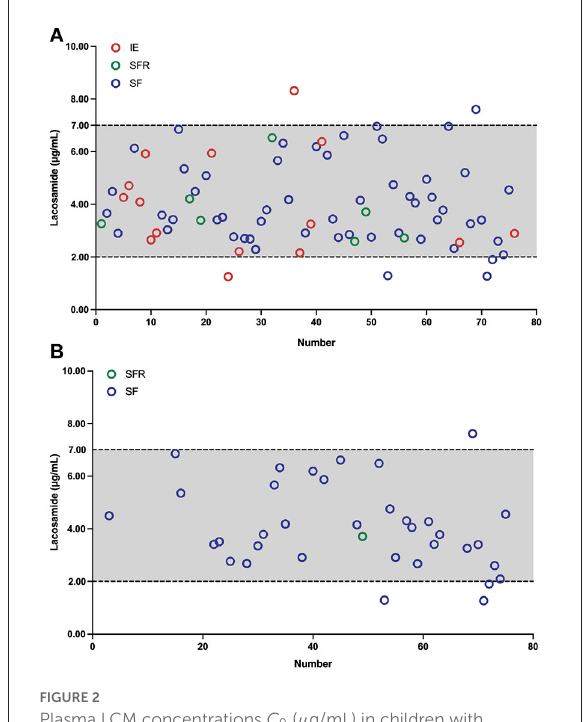
FIGURE2 Plasma LCM concentrations C 0 ( µ g/mL) in children with epilepsy, the x-axis shows the number of patients. Two dotted lines depict the measured C 0 values in our findings. Different colored circles denote C 0 measurements after the maintenance dosage. Red circles indicate C 0 measurements of the ineffectiveness (IE) group, green circles represent C 0 measurements of the seizure frequency reduction (SFR) group, and blue circles denote C 0 measurements of the seizure-freedom (SF) group, respectively. (A) As an adjunctive therapy, LCM C 0 ( µ g/mL) values in 76 children with epilepsy. (B) As a monotherapy, LCM C 0 ( µ g/mL) measurements in 36 children with